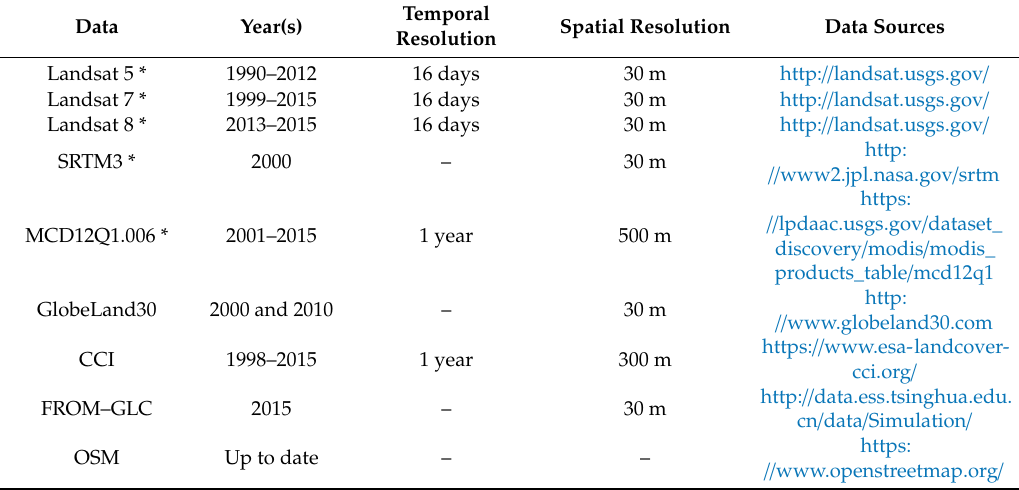
Table 1. Datasets used in this research. Note that Year(s) represents the temporal magnitude of the datasets used; * represents data available online (https: // earthengine.google.com). Landsat 5 / 7 / 8 are the satellite data. SRTM3 (Shuttle Radar Topography Mission Version 3) is the raster data. MCD12Q1.006, GlobeLand30, CCI and FROM–GLC are LULC (land use / land cover) products. OSM (Open Street Map) is the vector